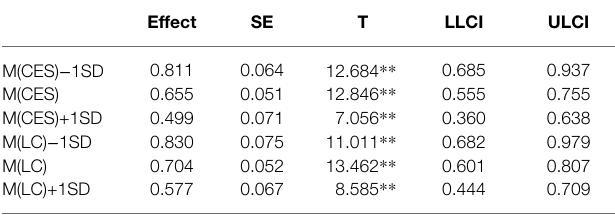
TABLE 6 | Results for simple slop tests.